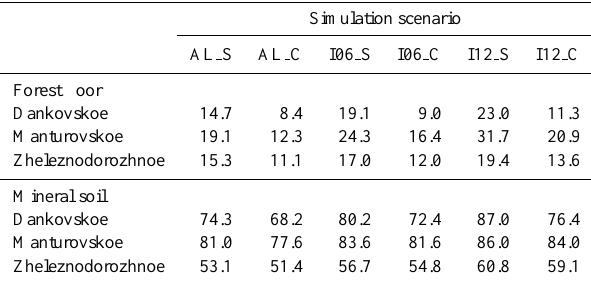
Table 5. Soil carbon (MgCha − 1 ) in soil compartments at dif- ferent levels of deposition of nitrogen compounds (AL – ambi-